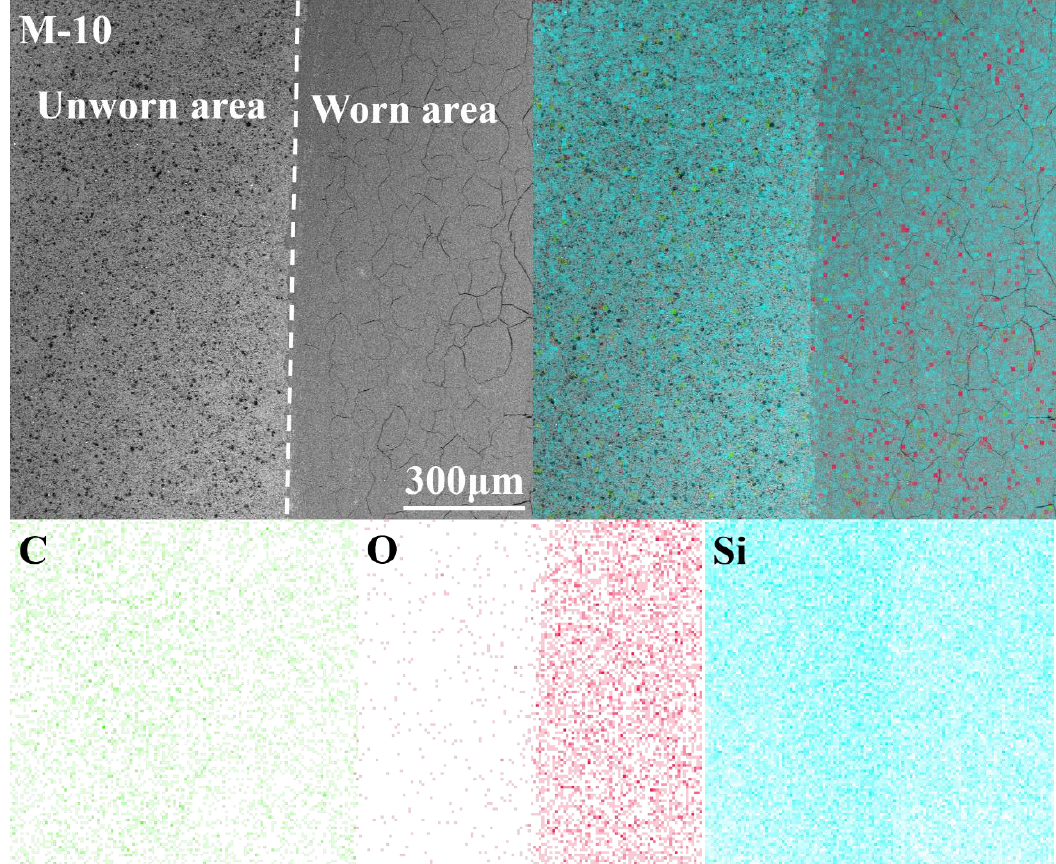
Figure 11. Energy dispersive spectrometer (EDS) images of sample M-10.